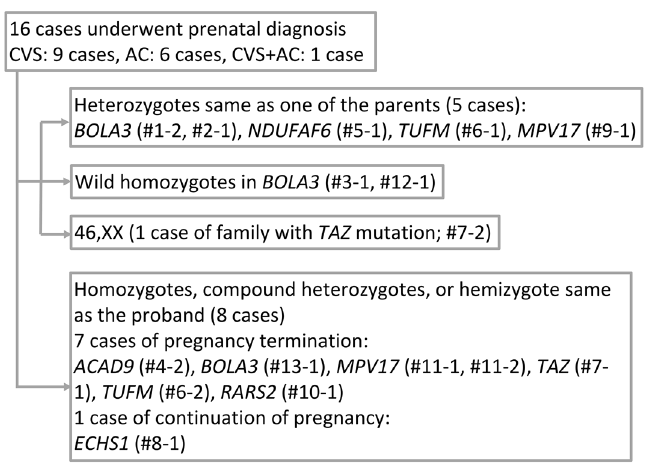
Figure 1. Results of prenatal testing. We conducted prenatal testing for 16 cases. Of them, eight fetuses were not affected, and the pregnancies were continued. The other eight fetuses had the same pathogenic variants as the proband. One family decided to continue the pregnancy and the other seven opted for the termination of pregnancy. CVS chorionic villus sampling, AC